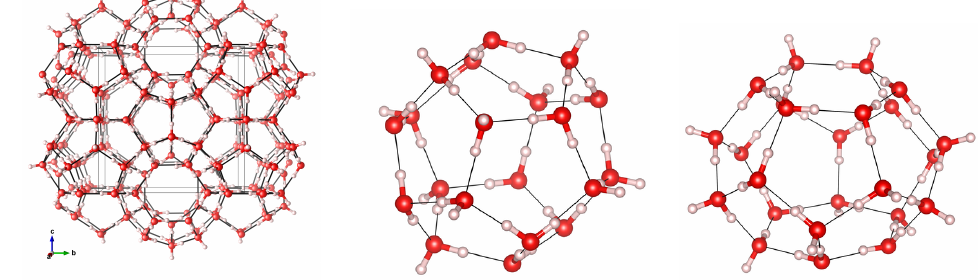
Figure 1. Unit cell ( left ) and P ( center ) and H ( right ) types of cages in the sI structure. Oxygen is shown in red and hydrogen is in white